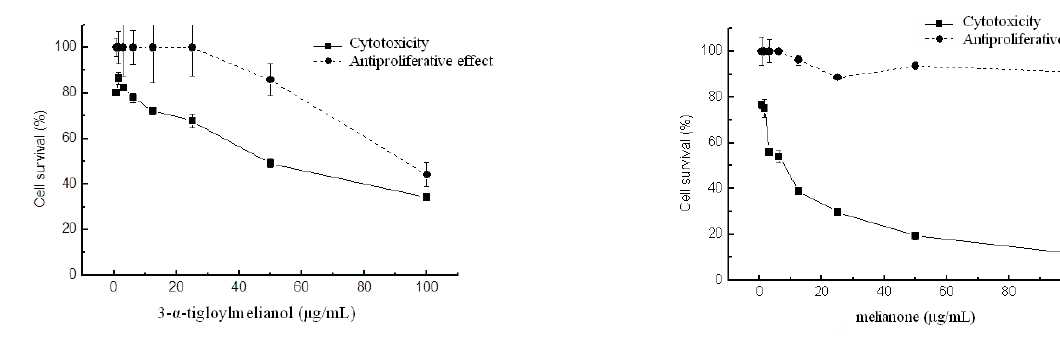
Figure 3. Regression curves of cytotoxic and antiproliferative activity of 3- α - tigloylmelianol and melianone against the tumorigenic cell line